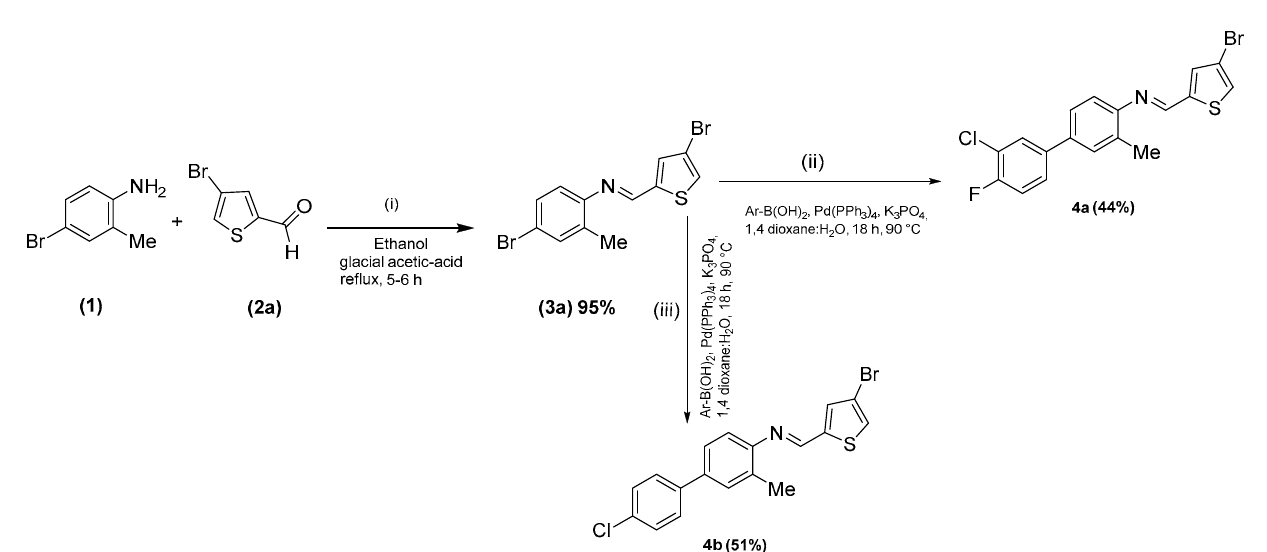
Scheme 1. Synthesis of ( E )-4-bromo- N -((4-bromothiophen-2-yl)methylene)-2-methylaniline ( 3a ) and Suzuki coupling of 3a with aryl boronic-acids. Reagents and conditions : (i) 1 (0.307 g, 1.612 mmol), 2a (0.307 g, 1.612 mmol), ethanol (10 mL), glacial acetic-acid (5–6 drops) (ii) 3a (0.200 g, 0.560 mmol), Pd(PPh 3 ) 4 (0.0321 g, 5-mol%), 3-chloro-4-fluorophenyl boronic acid (0.1165 g, 0.670 mmol), K 3 PO 4 (0.280 g, 1.340 mmol) (iii) 3a (0.330 g, 0.835 mmol), Pd(PPh 3 ) 4 (0.048 g, 5-mol%), 3-chlorophenyl boronic acid (0.160 g, 1.002 mmol), K 3 PO 4 (0.420 g, 2.005 mmol).